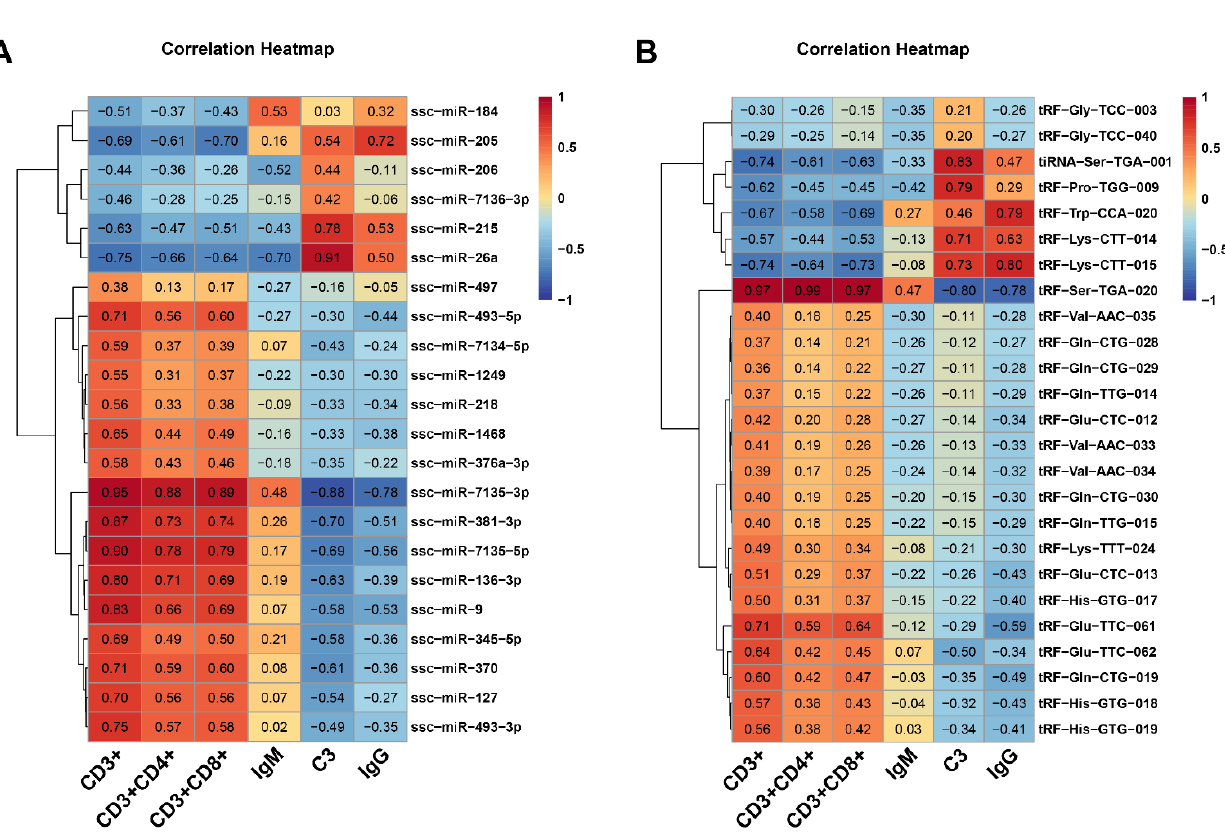
Figure 4. Correlation heatmap between the levels of immune-related indexes and DME ( A ) and DMT ( B